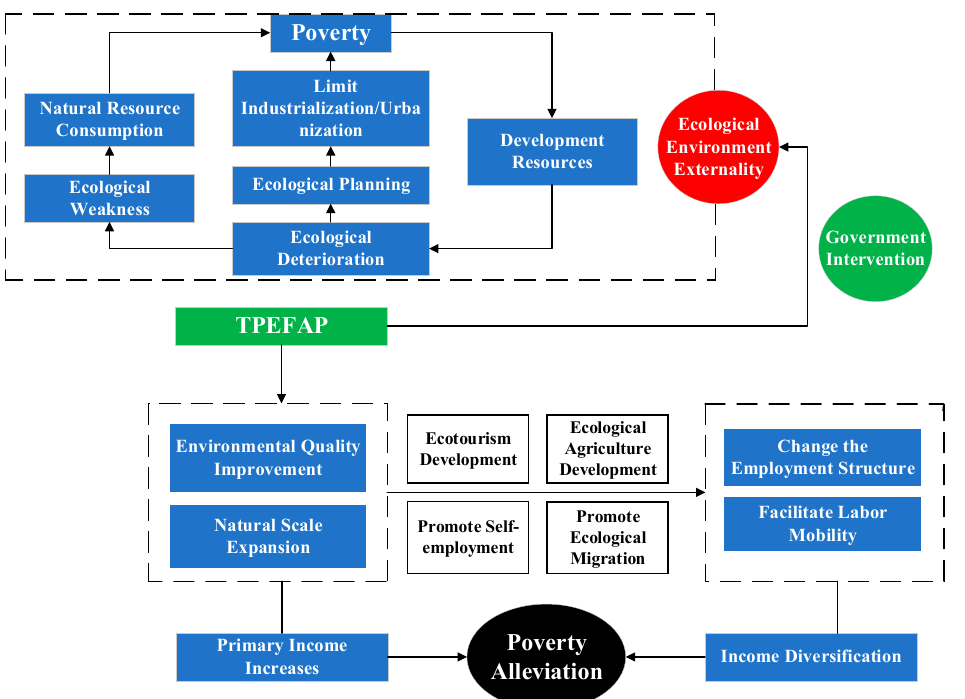
Figure 1. The expected synergism between ecological protection and poverty alleviation under the TPEFAP.